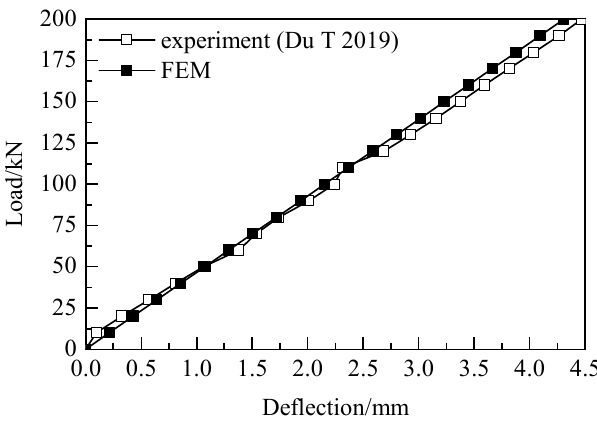
Figure 10. Load–deflection curve [26].